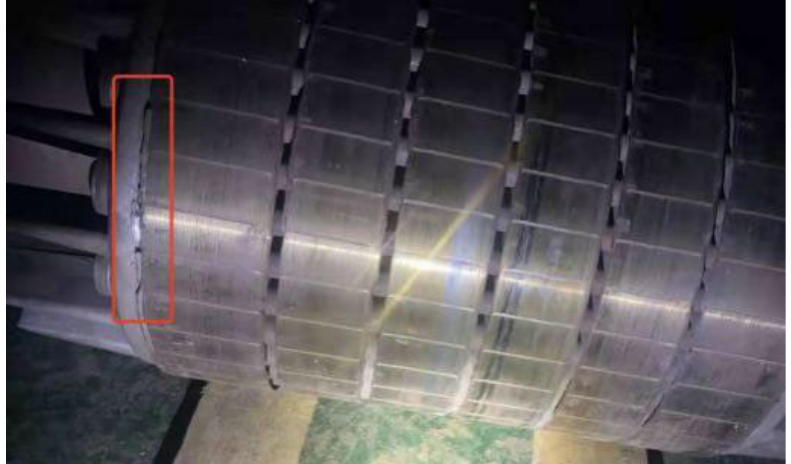
Figure 1. A faulty rotor.